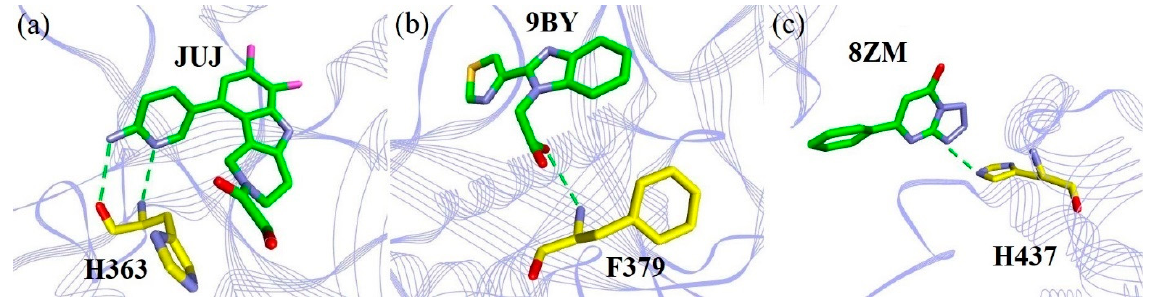
Figure 7. The binding details of ( a ) H363 and JUJ, ( b ) F379 and 9BY, and ( c ) H437 and 8ZM interactions. The green dashes represent the hydrogen bonding. The schemes of the atom and protein colors are the same as in Figure 5.